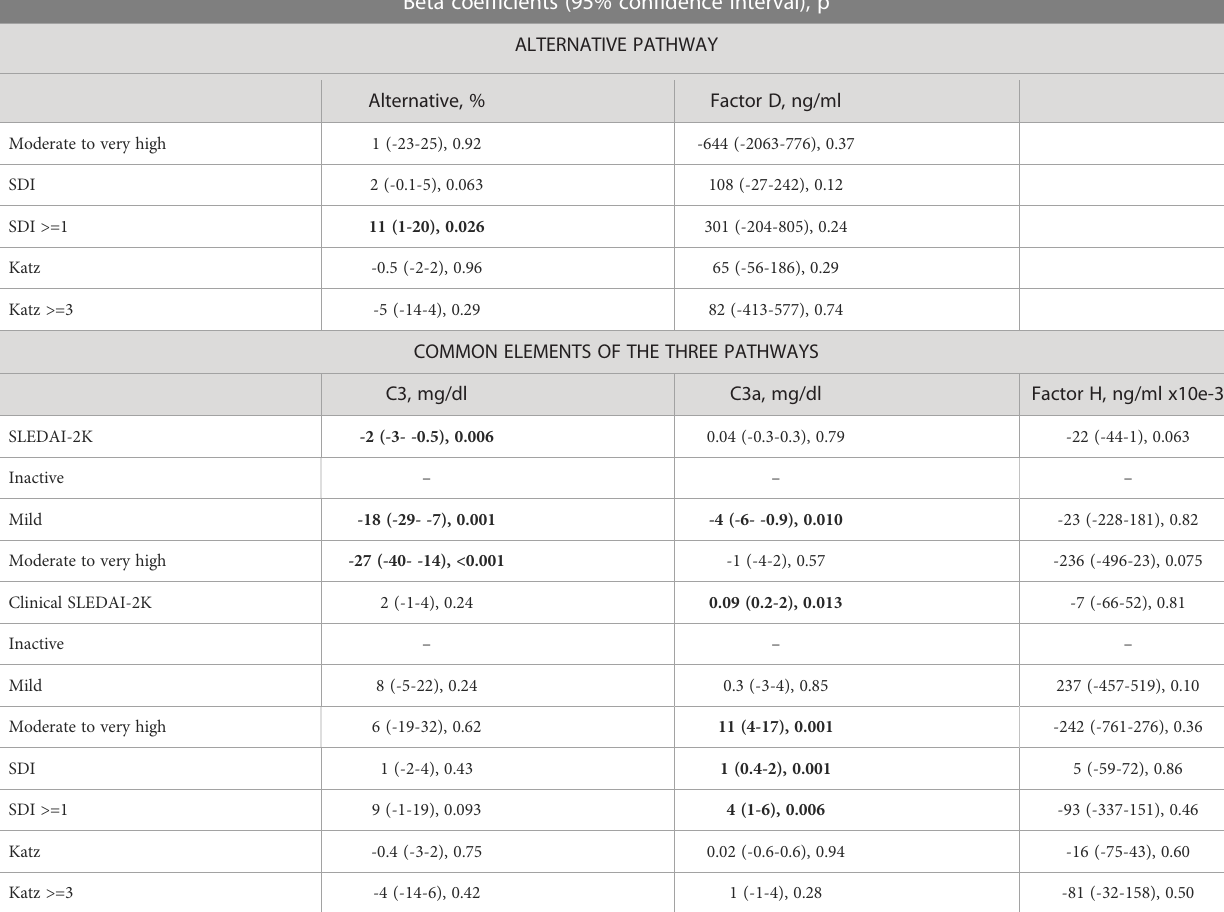
Clinical SLEDAI-2K does not account for anti-DNA antibodies or hypocomplementemia items. SDI: Systemic Lupus International Collaborating Clinics/American College of Rheumatology Damage Index. SLEDAI2-K: Systemic Lupus Erythematosus Disease Activity Index. SLEDAI categories were de fi ned as: 0, no activity; 1-5 mild; 6-10 moderate; >10 very high. *inactive SLEDAI-2K category used as reference level. Statistically signi fi cant values are depicted in